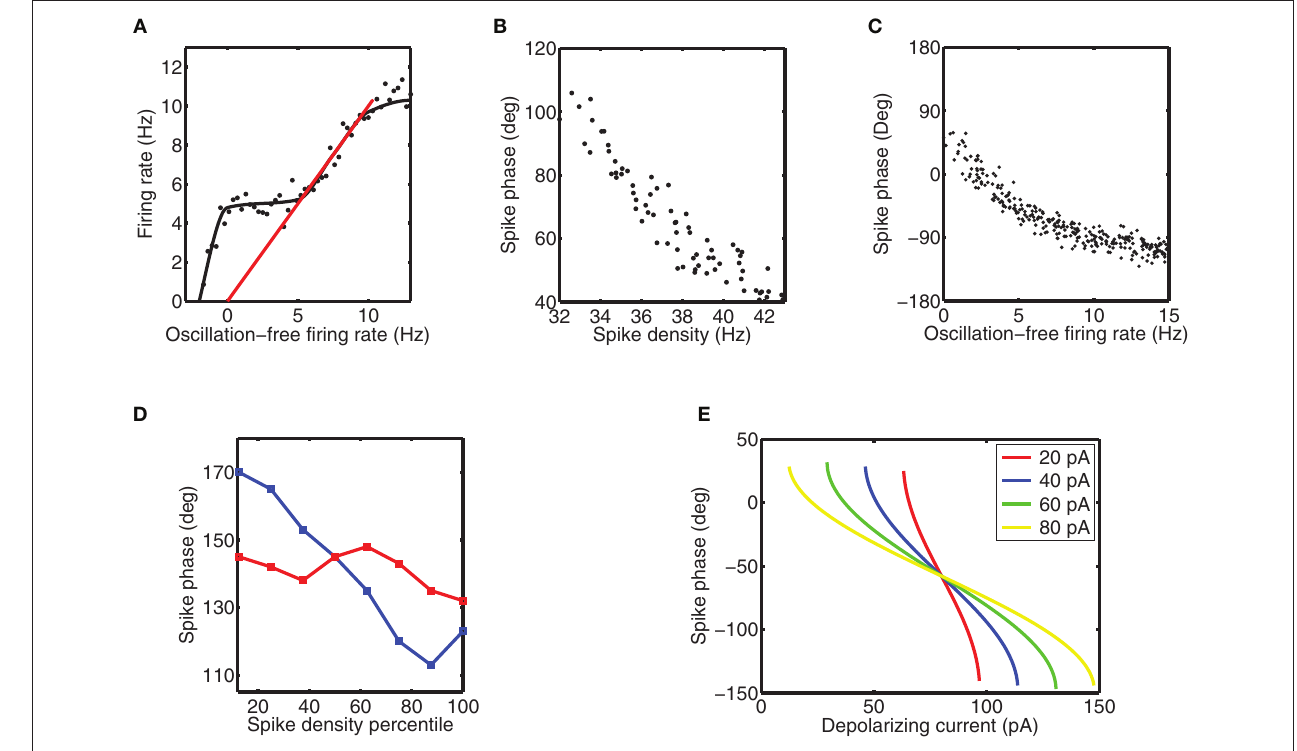
representation of the data shown in Figure 1F of McLelland and Paulsen (2009). (D) The range across which can be phase-shifted in vivo does depend on the degree of phase locking. The red curve is for strong phase-locking and the blue curve is for weak phase-locking. This graph schematically represents the data shown in Figure 6D of Vinck et al. (2010). (e) Phase-shifting can be studied analytically by determining the spike phase as a function of the level and depolarizing current for the leaky integrate-and-fire neuron for different amplitudes of the sinusoidal current (each indicated by a different line color according to the legend shown as inset). Because the precision of a neuron is proportional to the time derivative of the membrane potential at spike threshold (Cecchi et al., 2000), a higher amplitude of the sinusoidal current will improve precision and hence the phase-locking strength. The noise-less analytical results shown here predict that the range across which the phase can be shifted is not altered by amplitude. This graph is based on Figure 4A of McLelland and Paulsen (2009) (we show the case where the spike threshold exceeds the reset potential by 20